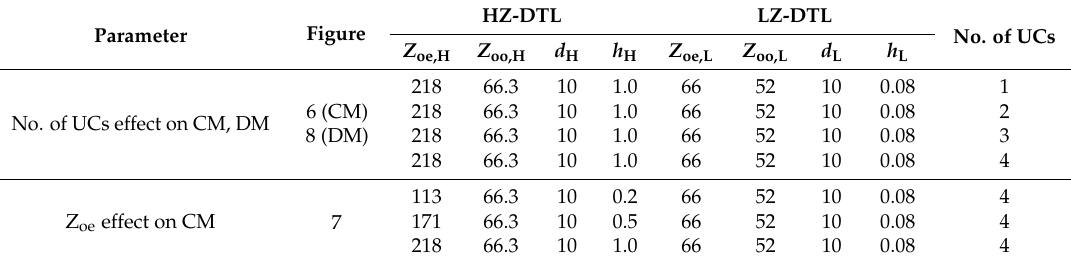
Table 1. Parameters for verification of the proposed analytical model. DTL—differential